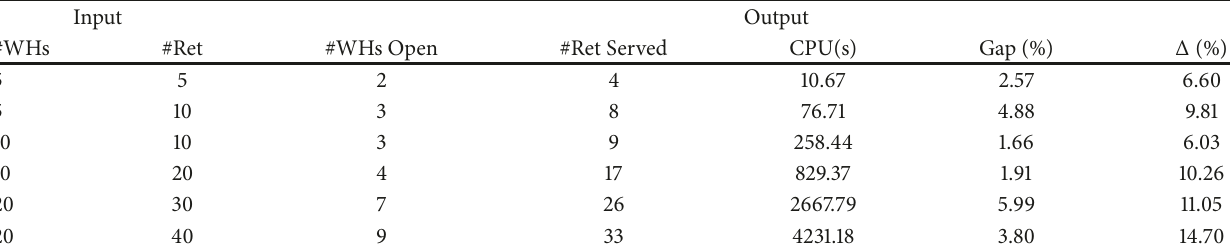
Table 6: The computational results for P with large